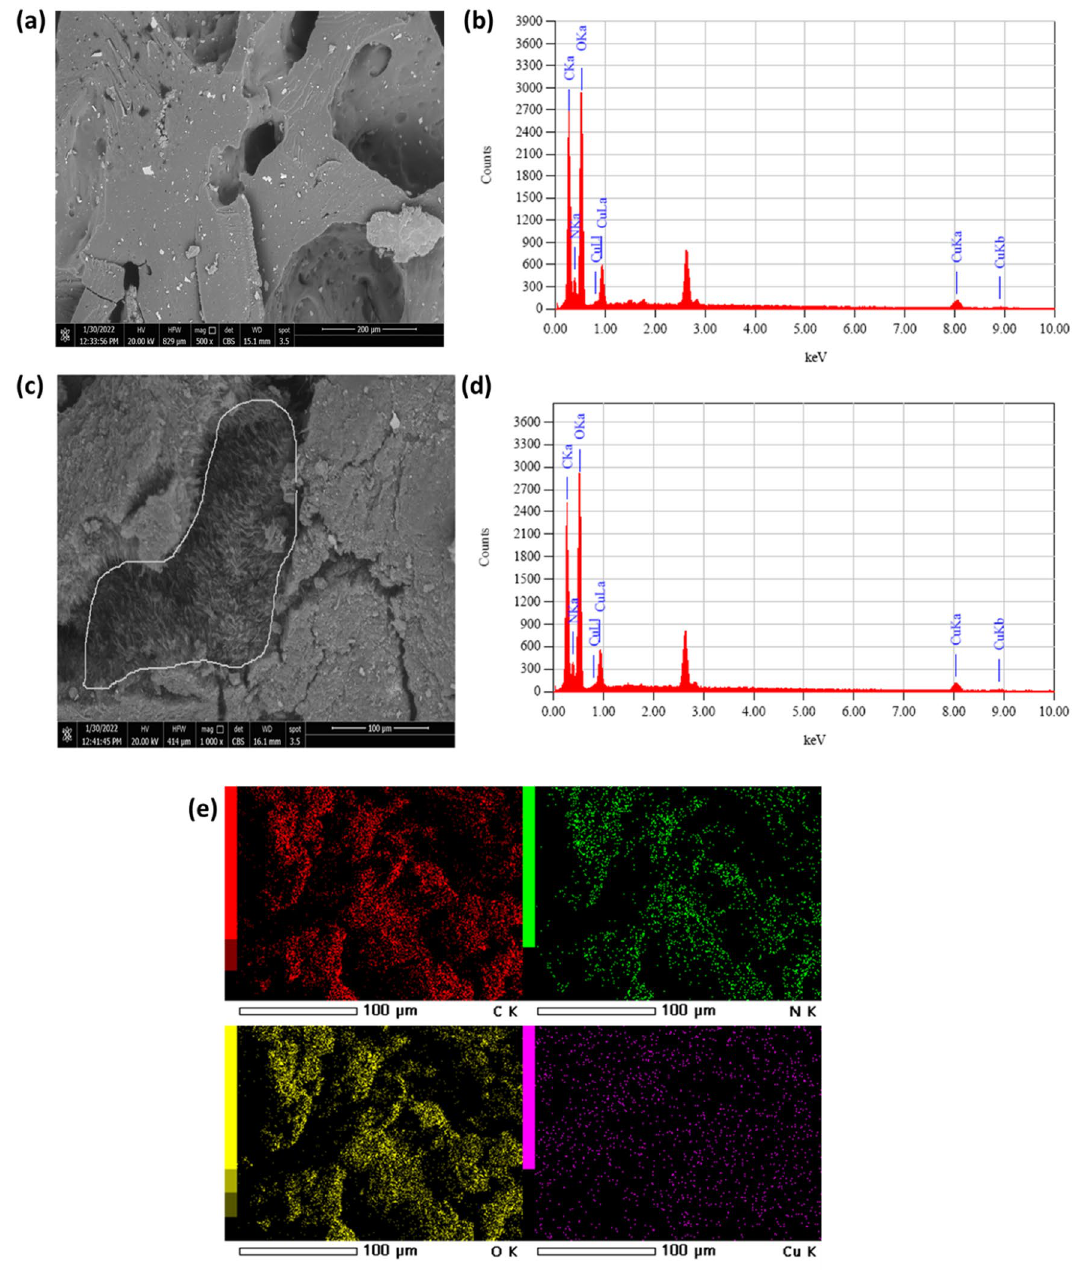
Figure 8. ( a ) SEM image of Cs-g-PVP/CuCl 2 ( b ) EDX profile of Cs-g-PVP/CuCl 2 ; ( c ) SEM of Cs-g-PVP/ MWCNTs/CuCl 2 ; ( d ) EDX profile of Cs-g-PVP/f-MWCNTs/CuCl 2 and ( e ) EDX mapping analysis of elemental constitutes of Cs-g-PVC/f-MWCNTs/CuCl 2